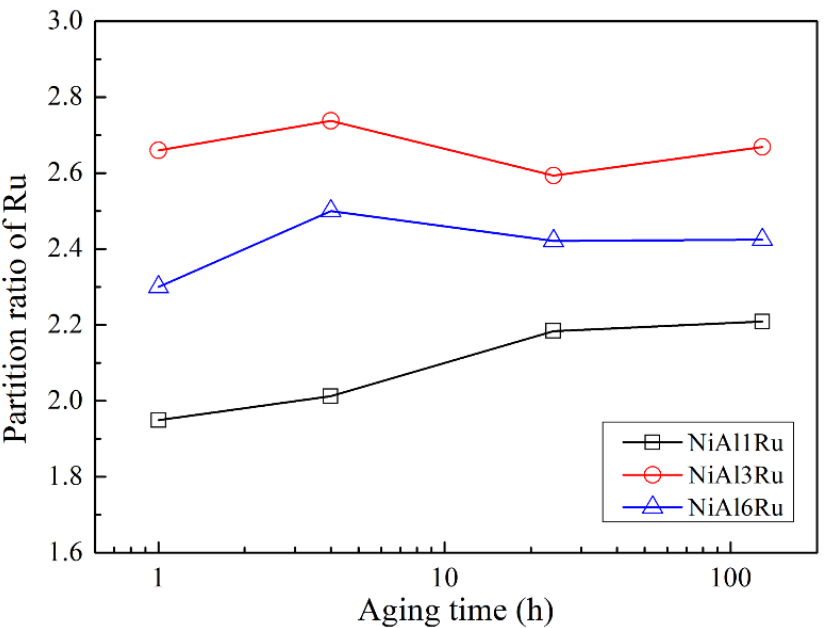
Figure 5. The partition ratios of Ru between γ and γ′ phases of the alloys after heat treatment. The horizontal x-axis is converted to logarithmic coordinates for clarity.